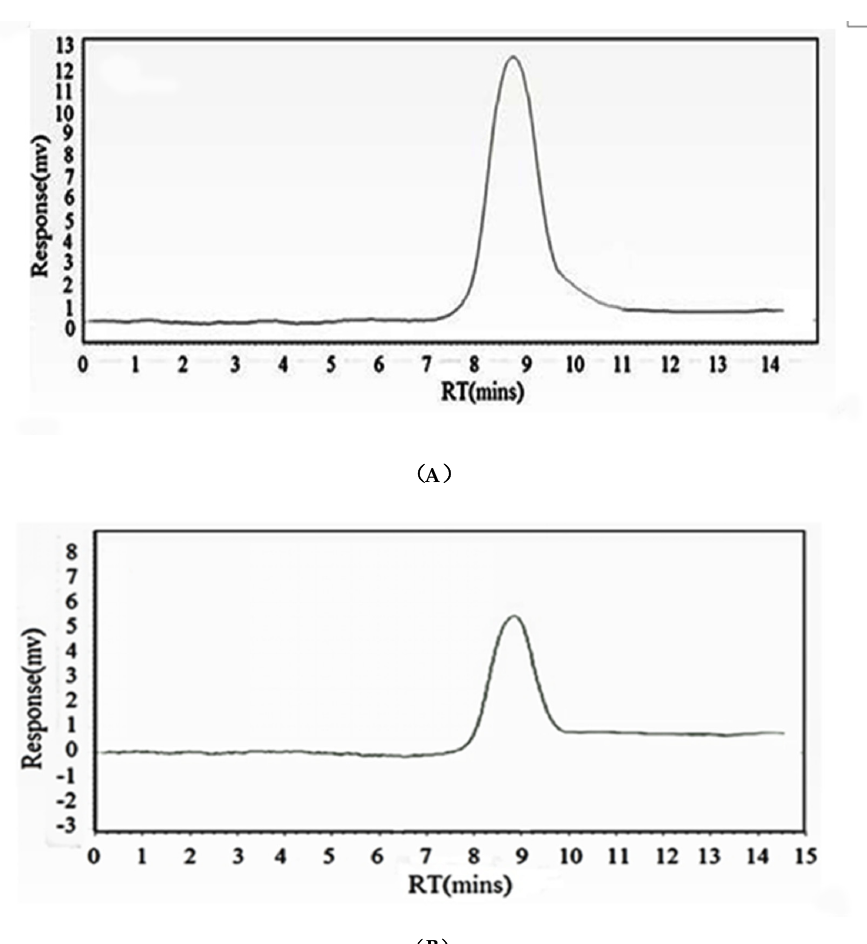
Figure 1. ( A ) Sephadex G ‐ 100 column chromatography for HIOP1 ‐ S; ( B ) Sephadex G ‐ 100 column chromatography for HIOP2 ‐ S.